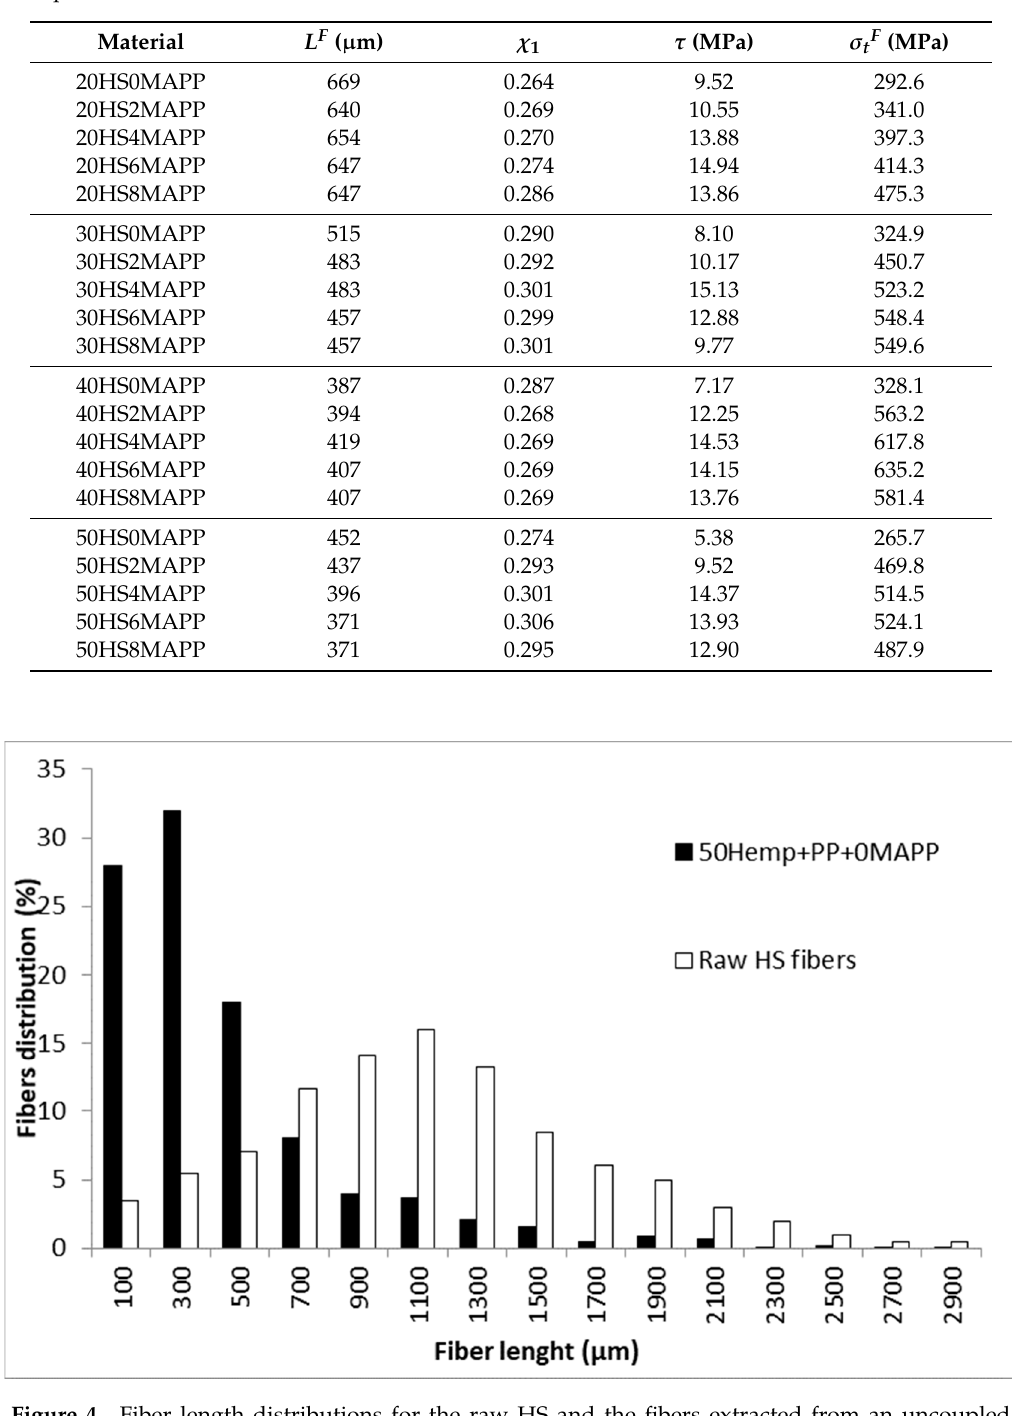
Table 2. Micromechanic properties of the tensile strength of the hemp strand reinforced poplypropylene composites.